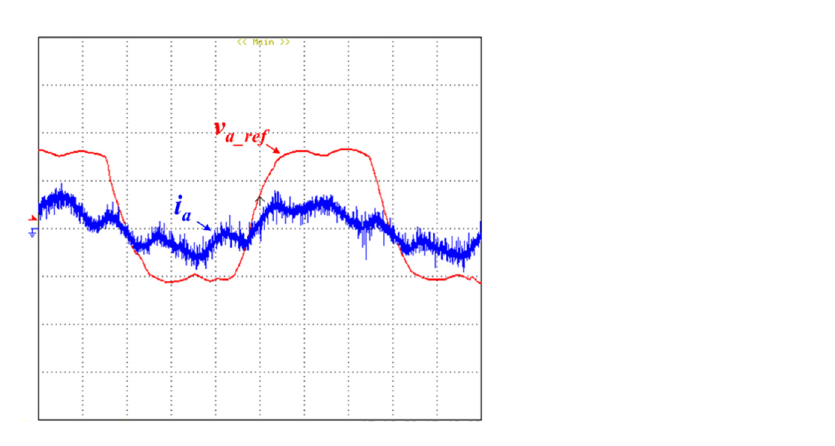
Figure 30. Reference signals for each leg of the power converter when the electric machine operates with a 45 Nm mechanical load (voltage: 2 V/div; time: 10 ms/div).